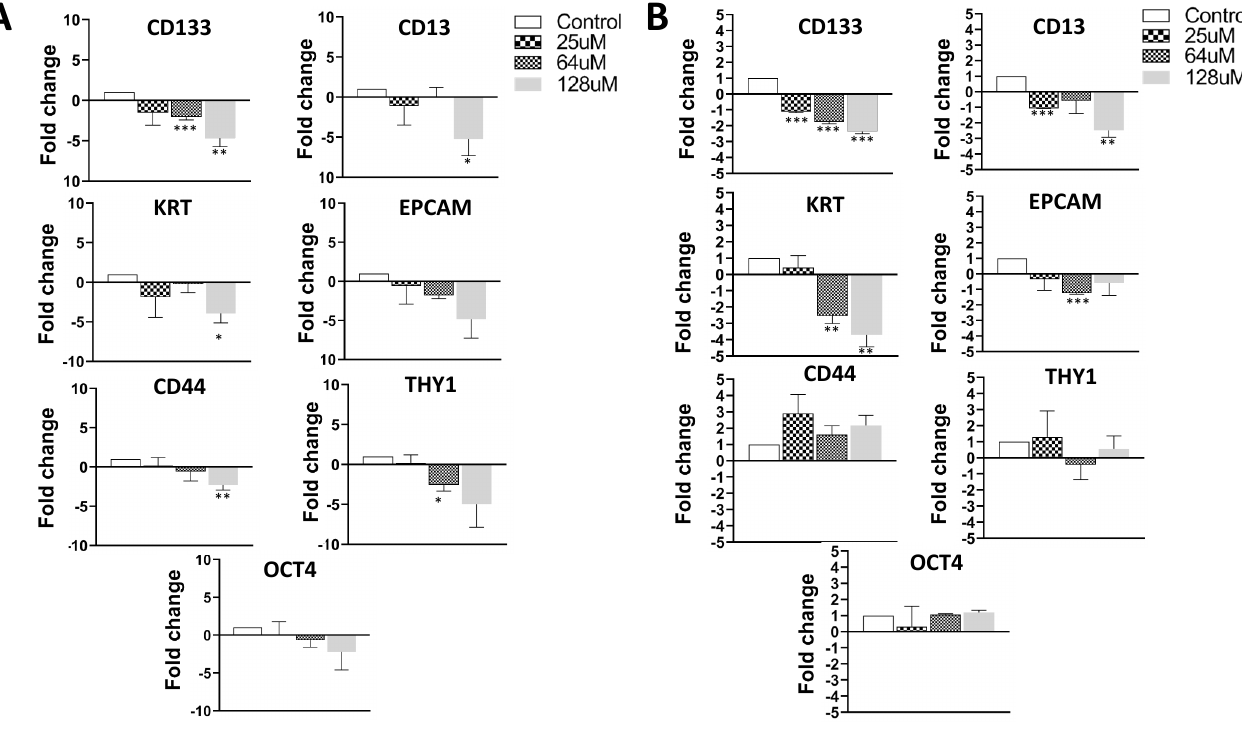
Figure 6. Treatment of cancer cells with AFM-1 and -2 leads to a reduction in the stem cell phenotype. ( A ) QRT-PCR results of the expression of stem cell markers in HepG2 cells treated with 25 µ M, 64 µ M, and 128 µ M. A significant reduction in the expression of CD133 was seen with 64 and 128- µ M dosing ( p = 0.001 and 0.006, respectively). There was also a decrease in CD13 and KRT seen at 128 µ M ( p = 0.040 and 0.014, respectively) and Thy1 at 64 µ M ( p = 0.011). * = p < 0.05, ** = p < 0.01, and *** = p < 0.001. ( B ) QRT-PCR results of the expression of stem cell markers in Hep3B cells treated